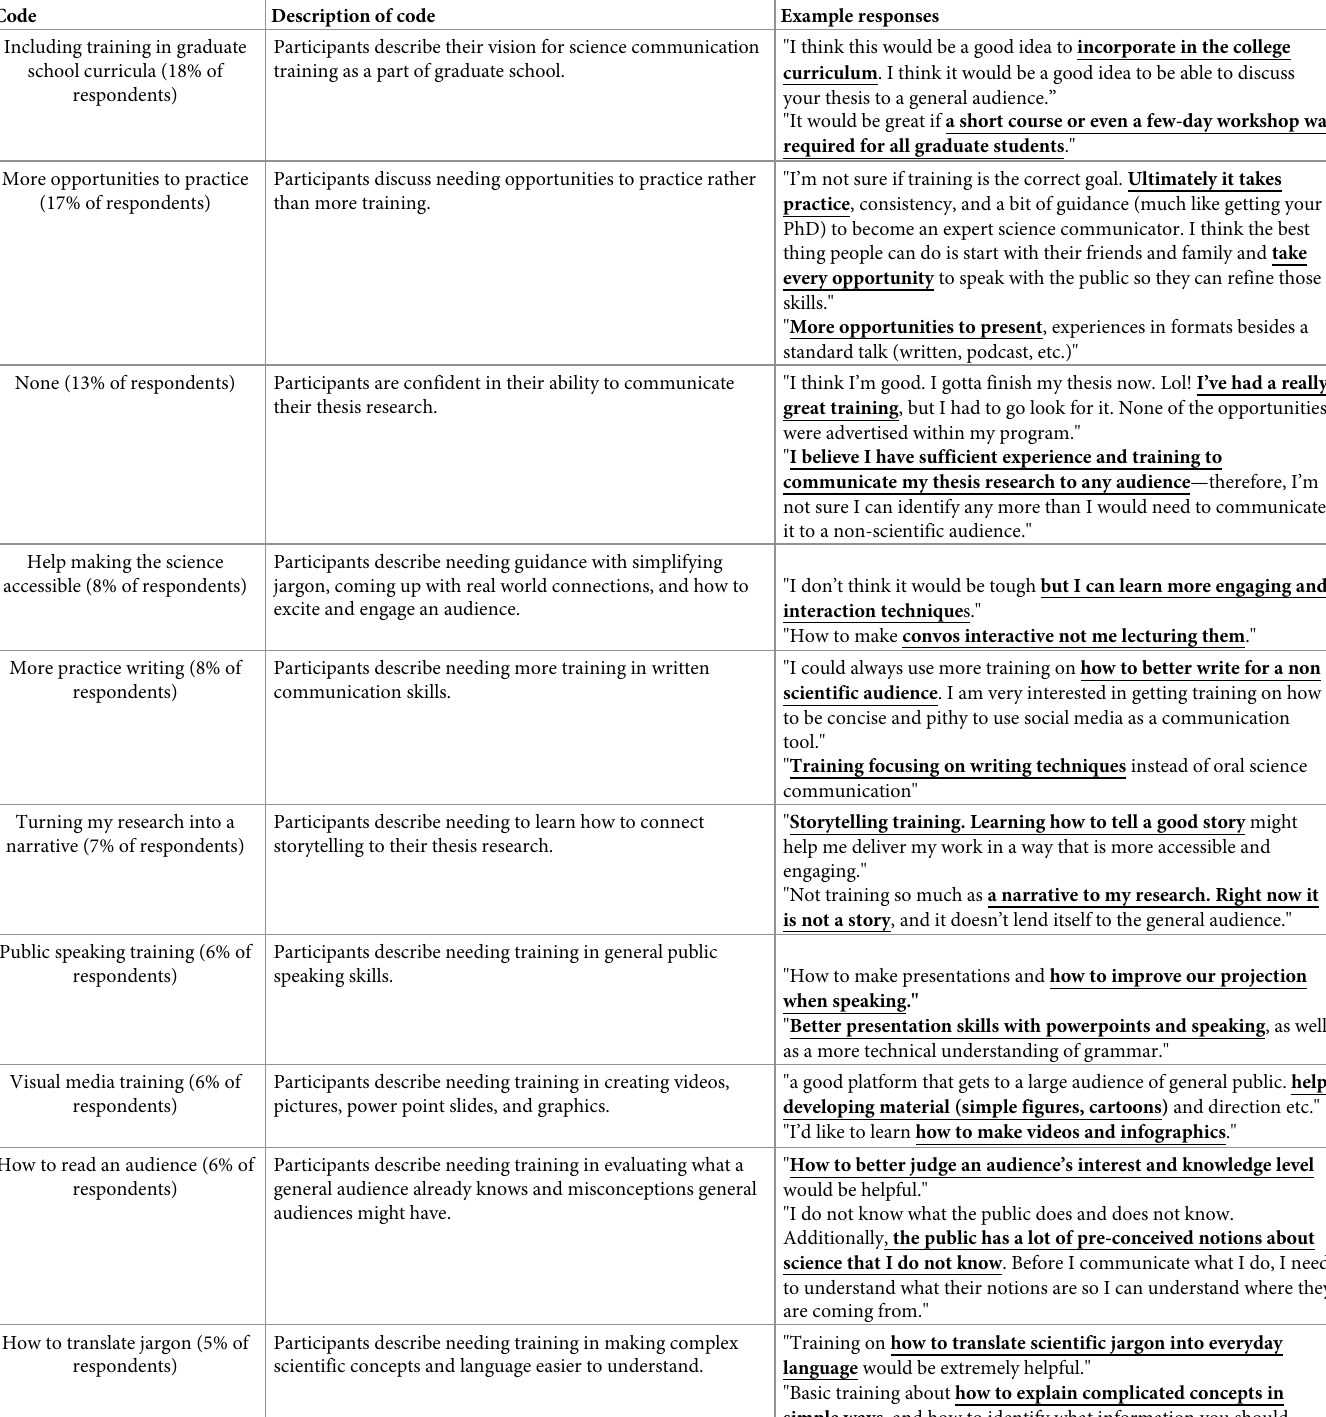
Table 9. We asked all participants “what additional training do you need to communicate your thesis research?” the resulting codes are shown in the left hand col- umn, with a description of each code in the center column, and example responses from participants in the right hand column. Text from each response that is directly relevant to each code is in bold and underlined